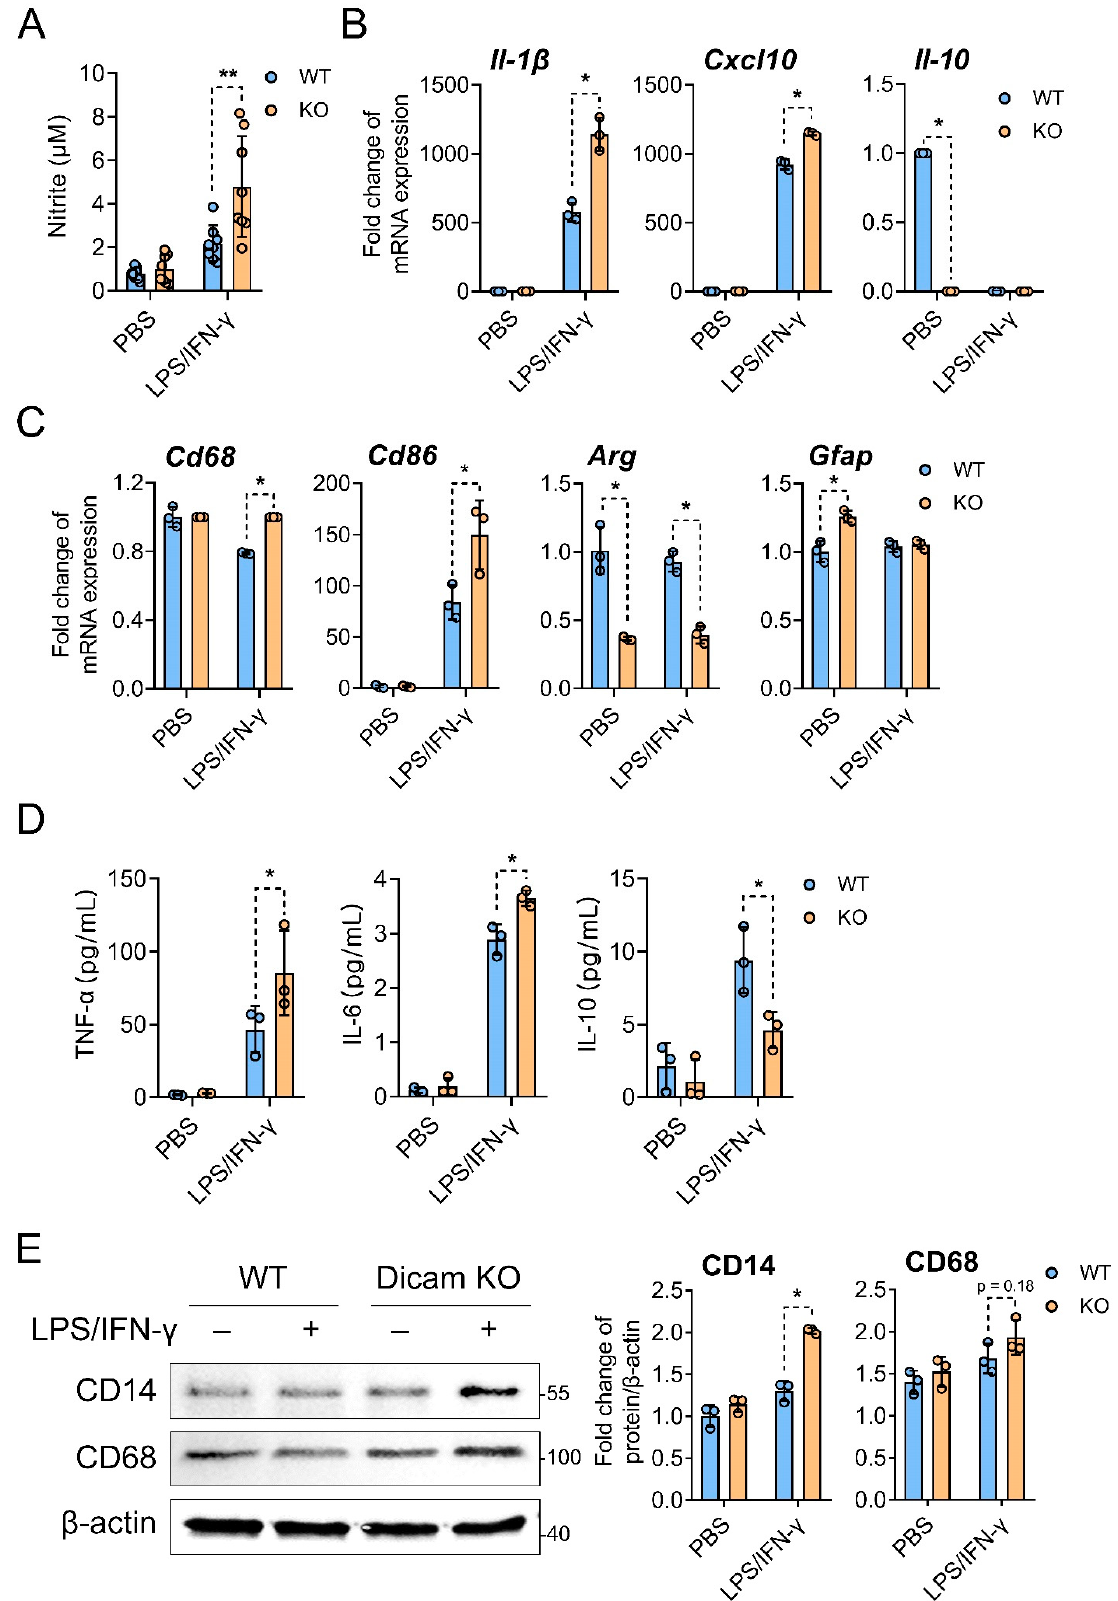
Figure 2. Deficiency of DICAM promotes the neuroinflammatory phenotype in primary mixed glia culture. ( A , D , E ) Primary mixed glial cells composed of astrocytes (~80% GFAP+ cells) and